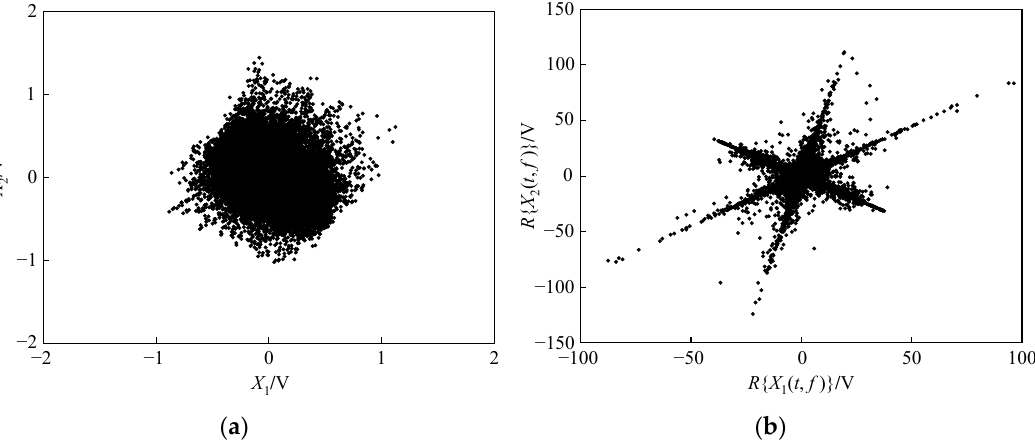
Figure 6. Scatter diagram of the mixed acoustic signals in time domain and time-frequency domain; (( a ): time domain; ( b ): time-frequency domain).